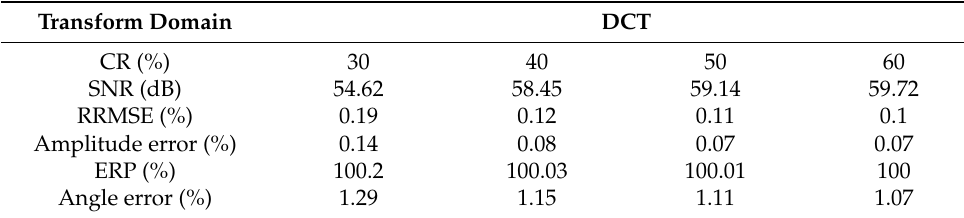
Table 4. Reconstruction results of voltage fluctuation signal in the DCT